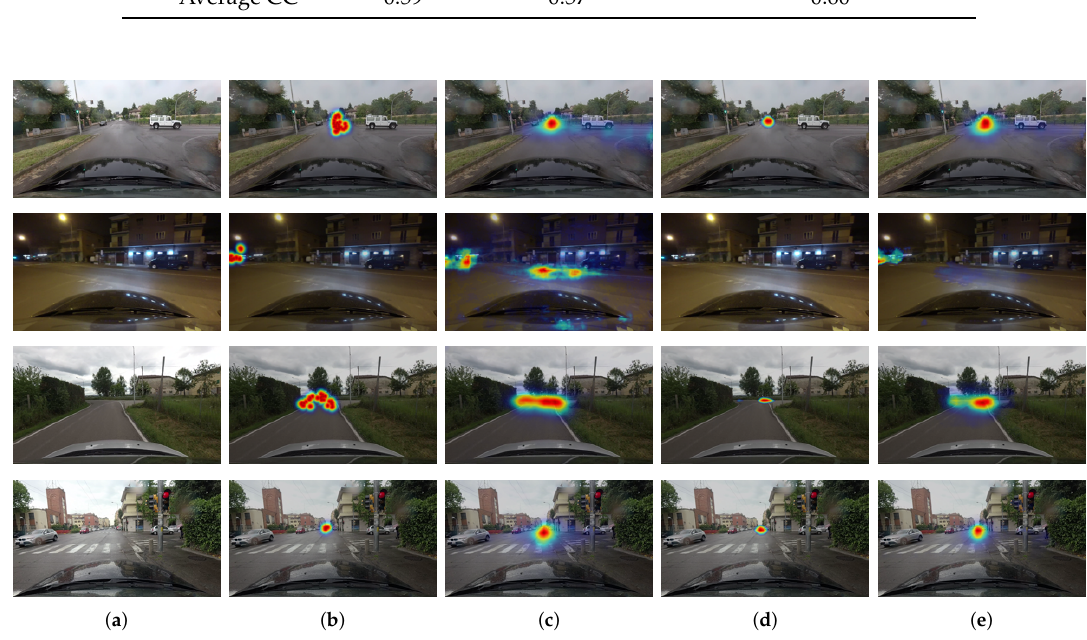
Figure 6. Visual comparisons of the predicted attention maps generated by different activation functions. ( a ) Input Image. ( b ) Ground-truth attention map. ( c ) Linear activation function. ( d ) Hyperbolic tangent. ( e ) Hard hyperbolic